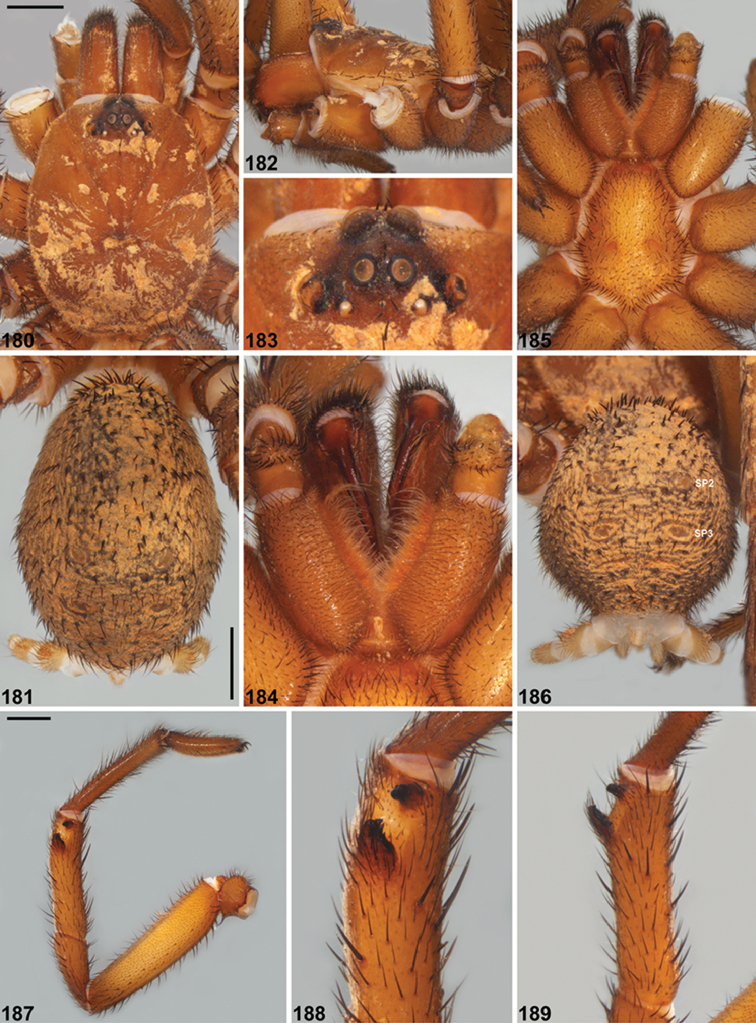

Idiosoma
gutharuka sp. n., male holotype (WAM T38517) from Gutha (Western Australia; AVW), somatic morphology. 180–181 Carapace and abdomen, dorsal view 182 Carapace, lateral view 183 Eyes, dorsal view 184 Mouthparts, ventral view 185 Sternum, ventral view 186 Abdomen, posterior view 187 Leg I, prolateral view 188 Leg I tibia, clasping spurs, prolateral view 189 Leg I tibia, proventral view. Scale bars 2.0. SP2–3 = sigilla pairs 2–3.